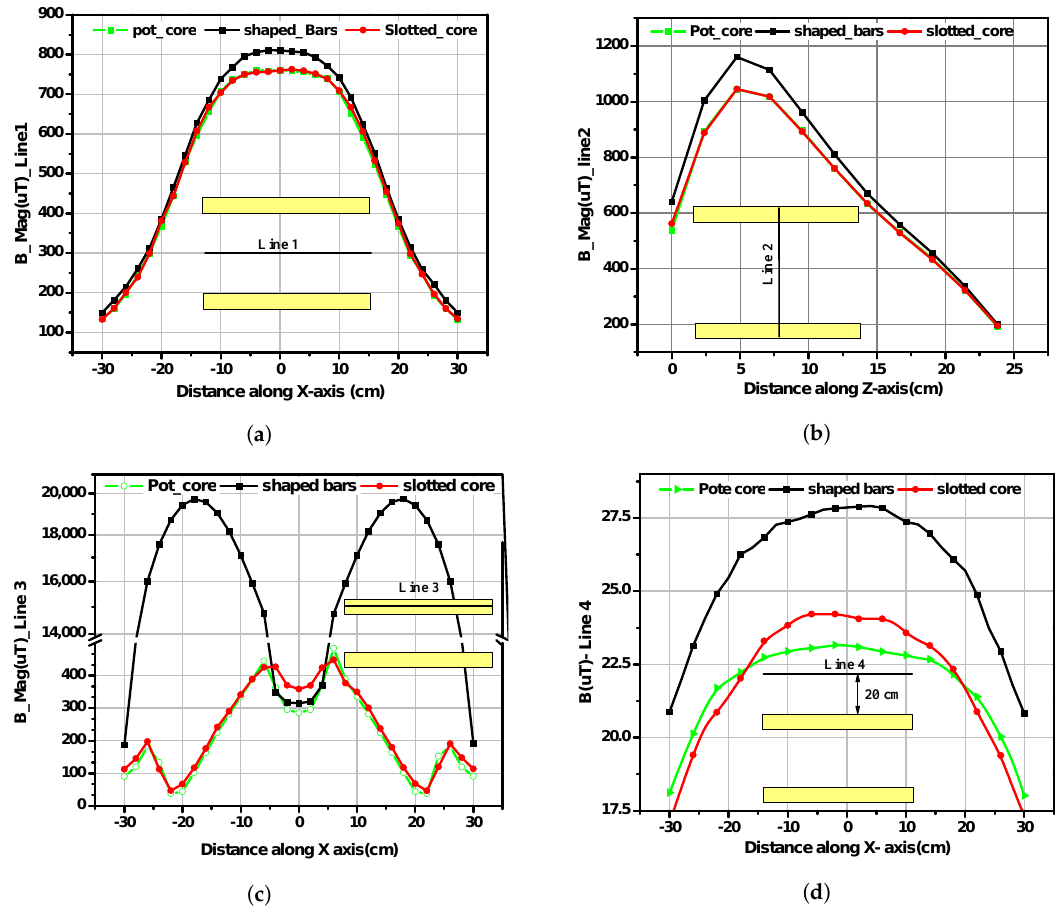
Figure 8. EMF level evaluation for the proposed cores. ( a) B _ Mag . on Line 1; ( b ) B _ Mag . on Line 2; ( c ) B _ Mag . on Line 3; ( d ) B rms on Line